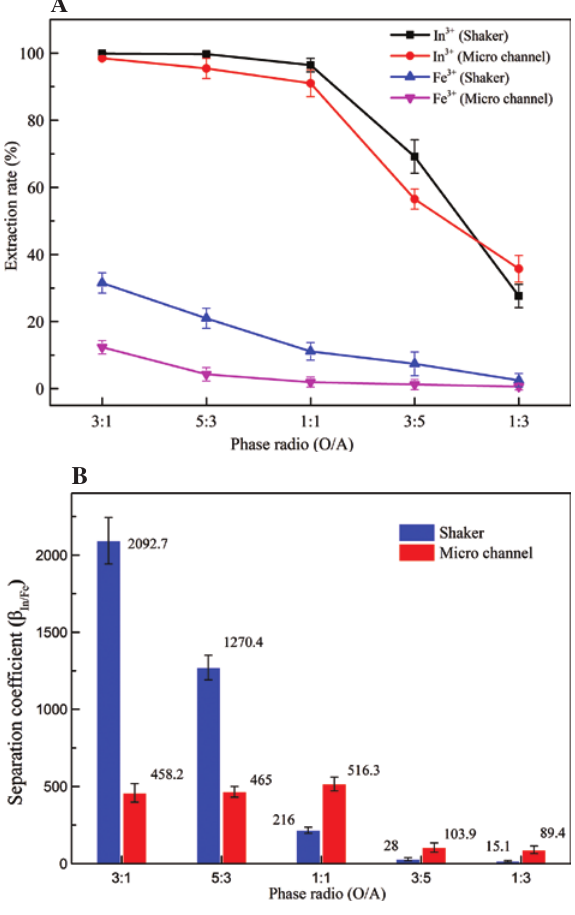
Figure 6: Effect of phase ratio (O/A): (A) effect of phase ratio (O/A) on the extraction rate, (B) effect of phase ratio (O/A) on the separation coefficient. Aqueous phase: [In 3 + ] = 2.59 g l − 1 , pH = 0.5, = 30%; O/A = 3:1–1:3, [Fe 3 + ] = 2.12 g l − 1 ; organic phase: ϕ D2EHPA Q = 20.16 μ l/min, T = 298